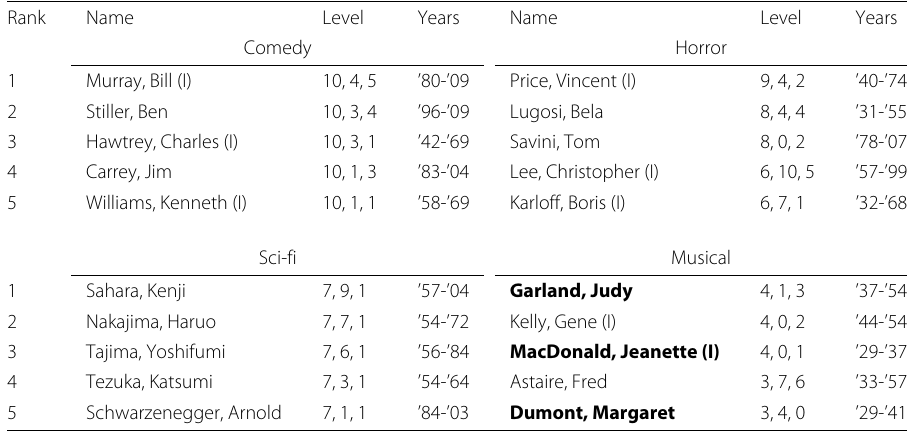
Table 10 Top 5 actors (of any gender, actresses in bold) by genre, for comedy, horror, sci-fi and musical